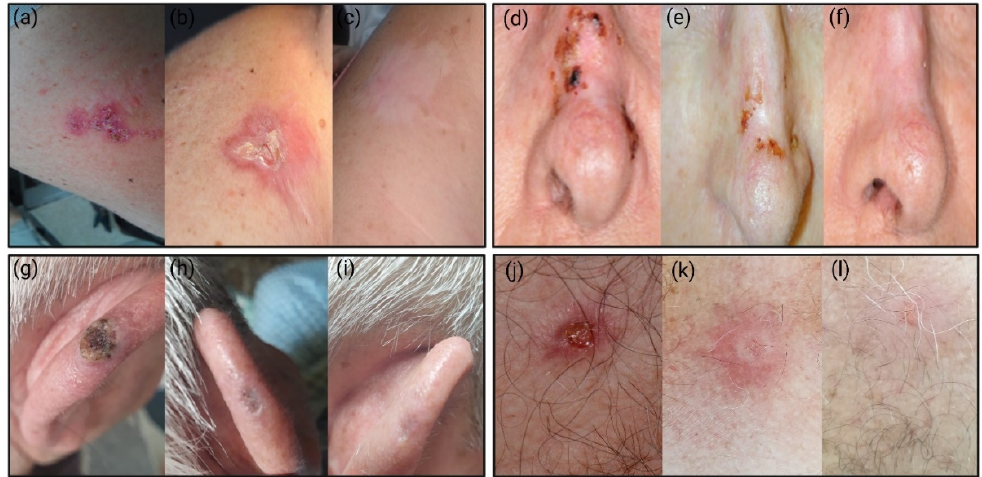
Figure 3. Initial ( a , d , g , j ), intermediate ( b , e , h , k ), and 12-month follow-up ( c , f , i , l ) clinical appearance in four patients with different BCC localizations (arm, nose, auricle, and anterior thorax). The 12- month evaluation displays satisfactory cosmetic